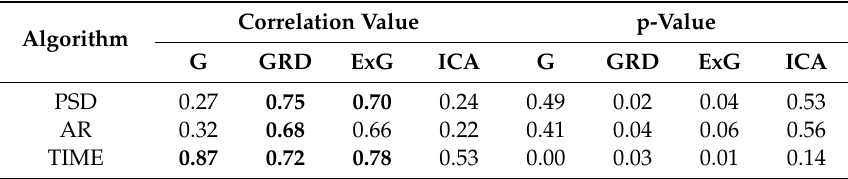
Table A12. The Pearson’s correlation values between the sRate and the standard deviation of the accelerations.